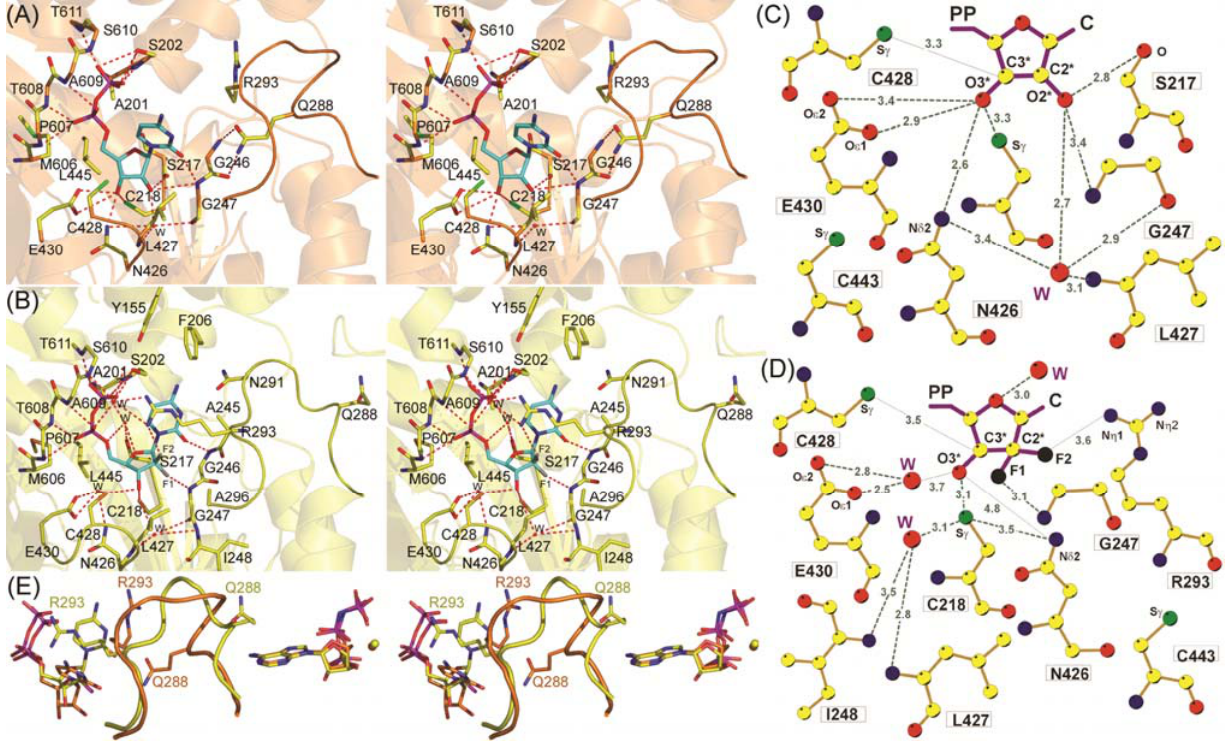
dCDP taken from Xu et al. , PNAS Figure 6. Catalytic site interactions of CDP and F 2 2006. ( A ) Stereo view of CDP (orange). Interacting atoms: oxygen, red; nitrogen, blue; phosphate, magenta; sulfur green; substrate carbons, cyan; protein non-C α , yellow; C α , as dCDP. Interacting atoms are colored as secondary structure, orange. ( B ) Stereo view of F 2 in ( A ) above except sulfur orange; C α carbons, as secondary structure, yellow; fluorines, grey. ( C ) Ligand plot of CDP ribose interactions. Colors are as in Figure 6(A), except that carbons are yellow and fluorine, black. ( D ) Ligand plot of F dCDP interactions. The van 2 der Waals contact to L427 is omitted for clarity. ( E ) Stereo view of loop 2 superposition of AMPPNP-CDP (orange) and AMPPNP-F dCDP (yellow). Substrate/inhibitor is seen on 2 the left and the effector is on the right. Reproduced with permission from PNAS . Copyright (2006) National Academy of Sciences, USA